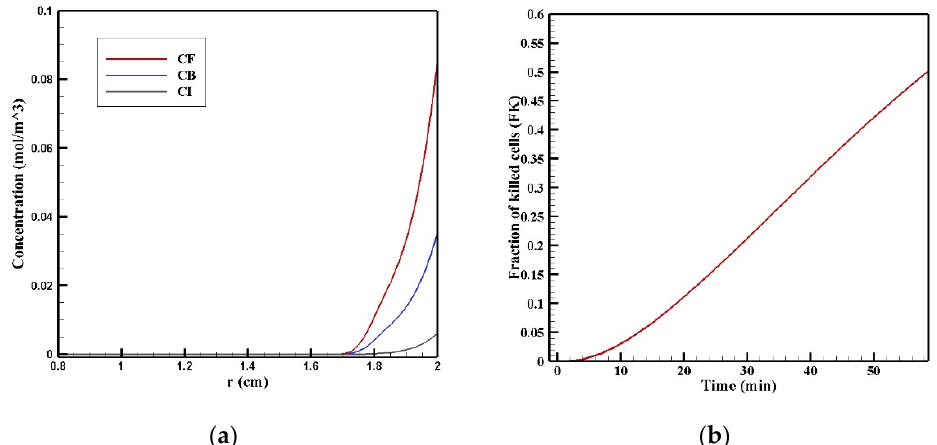
Figure 11. ( a ) Diagram of the mean concentrations of free (C F ), bound (C B ), and internalized drug (C I ) after 60 min; ( b ) killed cells fraction (FK) during 60 min of chemotherapy with intraperitoneal injection.